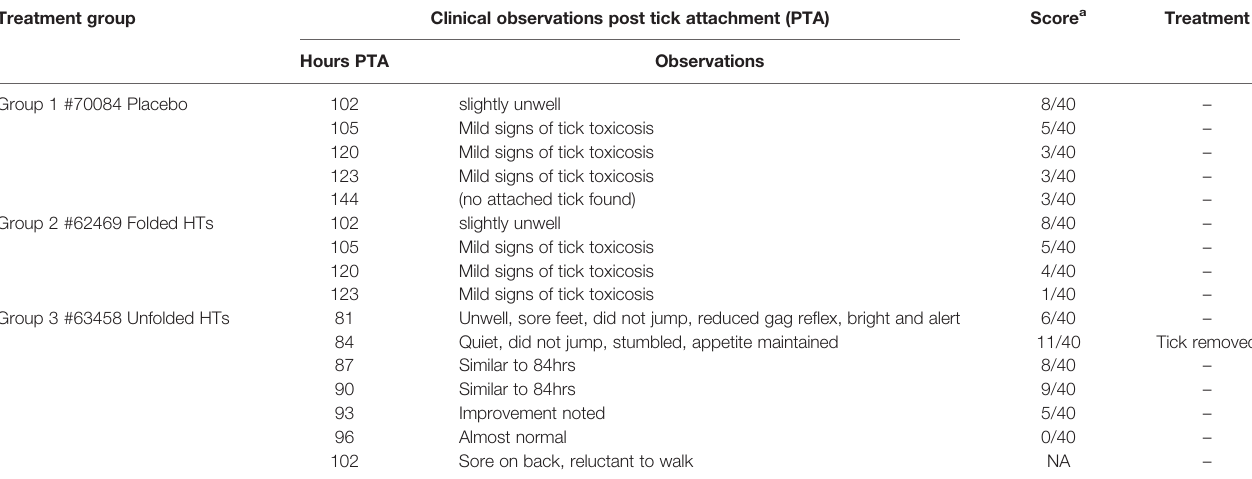
TABLE 2 | Trial 1 clinical data for cocktail vaccine HT1, HT2, HT3, HT4, HT12 as folded vs unfolded immunizations. Treatment group Clinical observations post tick attachment